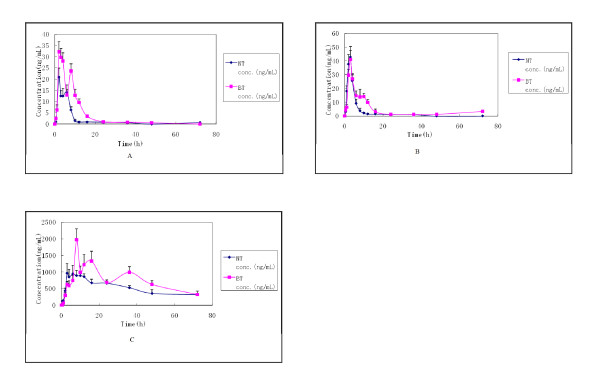
Mean concentration-time profiles of Notoginsenoside R1 (A), Ginsenoside Rg1 (B) and Ginsenoside Rb1 (C) in beagle dog plasma after oral administration of two types of tablets, Normal tablet (NT) and Bio-adhesive tablet (BT). The dose of oral administration of PNS is 90 mg/kg (n = 6).